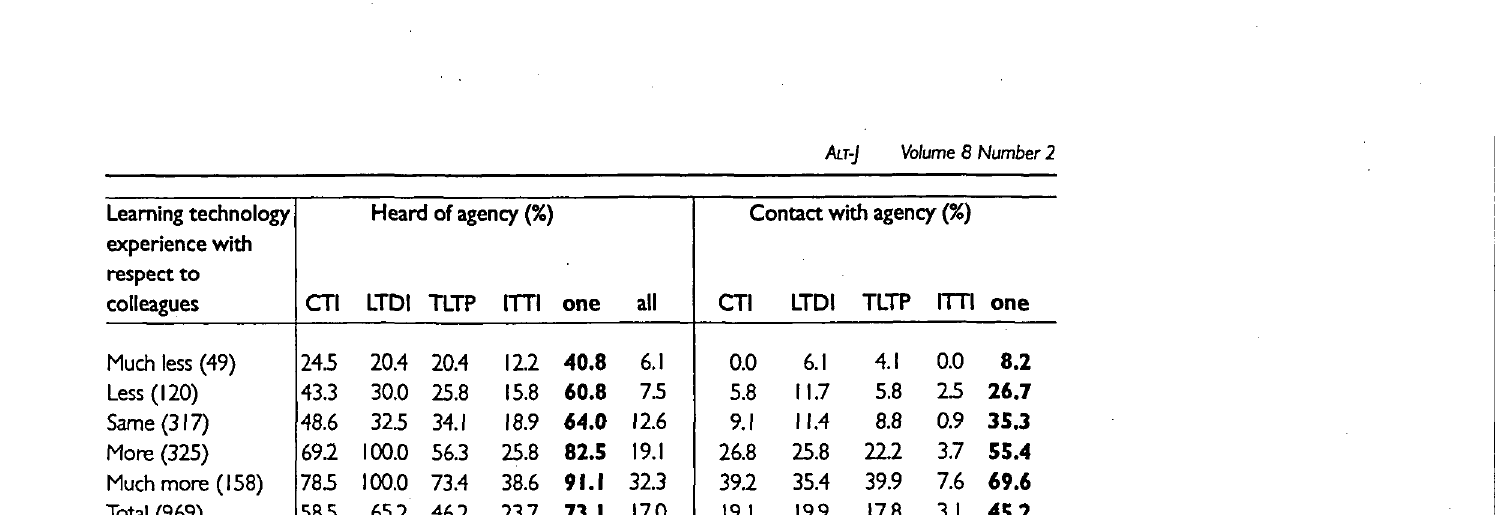
Table 2: Awareness of, and contact with, learning technology agencies by academic staff grouped by self-rating of their own experience with the use of learning technology relative to that of their colleagues.The numbers of respondents in each experience group is shown in parentheses. Other columns show the numbers of respondents in each experience category as percentages of total respondents in that category. The sixth and twelfth columns (in bold) show awareness or contact with any one of the four agencies. Only 969 out of the 982 respondents could be included in this analysis due to incomplete returns. Very few respondents reported contact with all agencies and so these data are